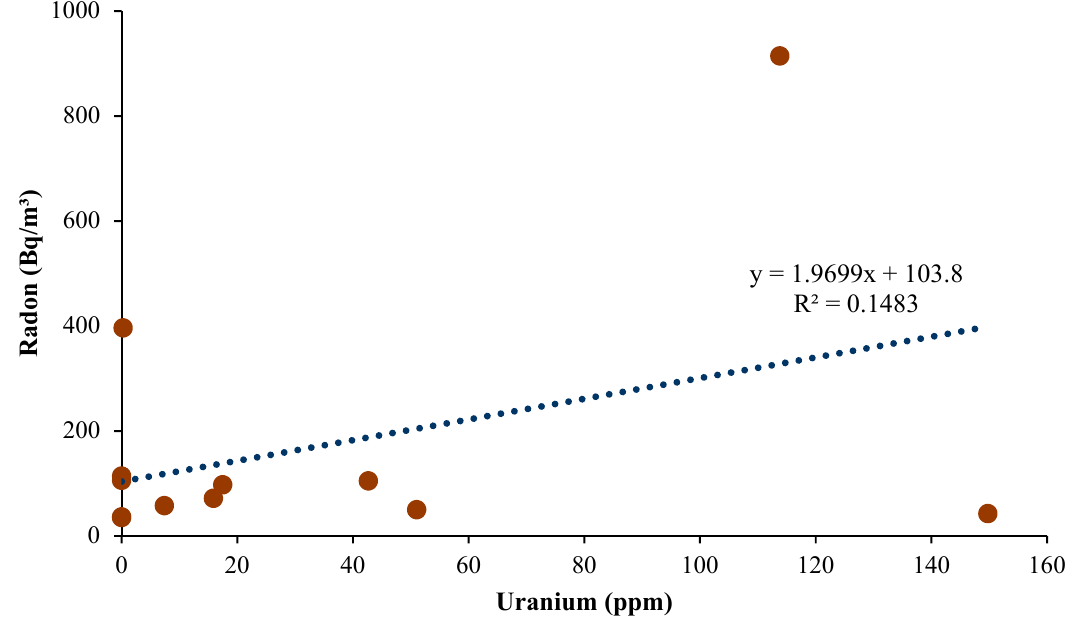
Figure 7. A histogram plot presenting outdoor radon concentration .